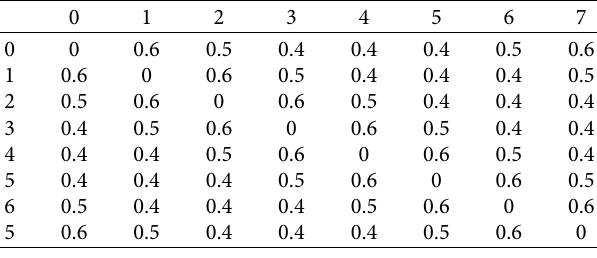
Table 5: Referee’s sensitivity to matches according to Figure